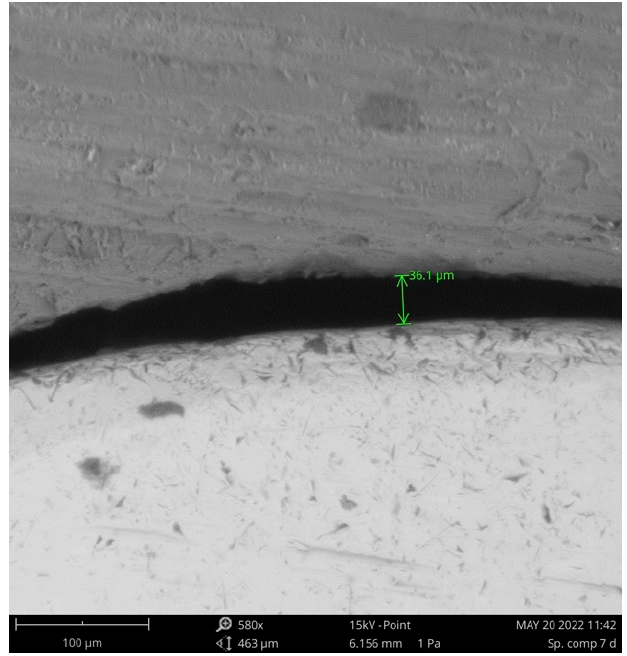
Figure 4. A 580× SEM image for evaluation of marginal gap at restoration-abutment interface. Figure 4. A 580 × SEM image for evaluation of marginal gap at restoration-abutment interface.